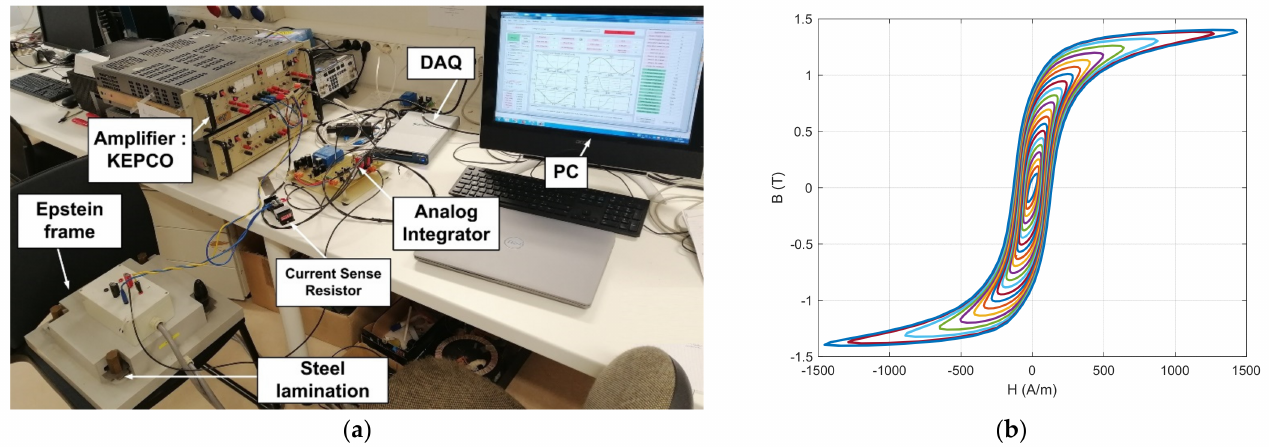
Figure A1. Magnetic material characterization for the Si-Fe lamination used in the E-shaped motorette: ( a ) test setup using an Epstein frame; ( b ) measurement sample of the BH loop at 400